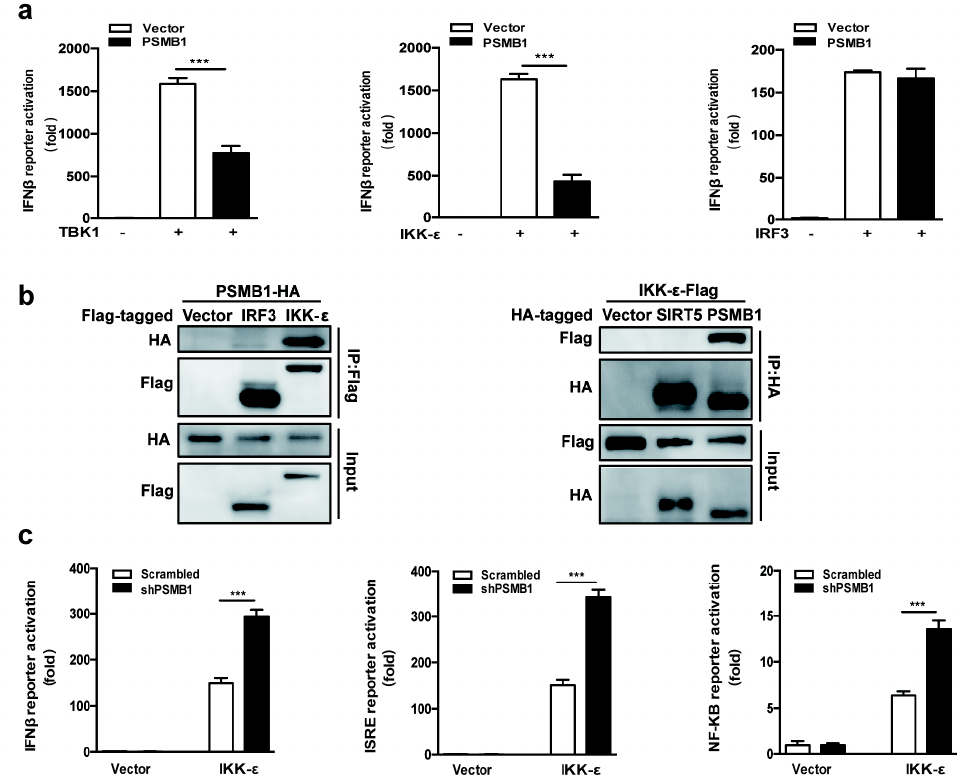
Figure 4. I κ B kinase ε (IKK- ε ) is the target of PSMB1. ( a ) PSMB1 inhibits RLR and